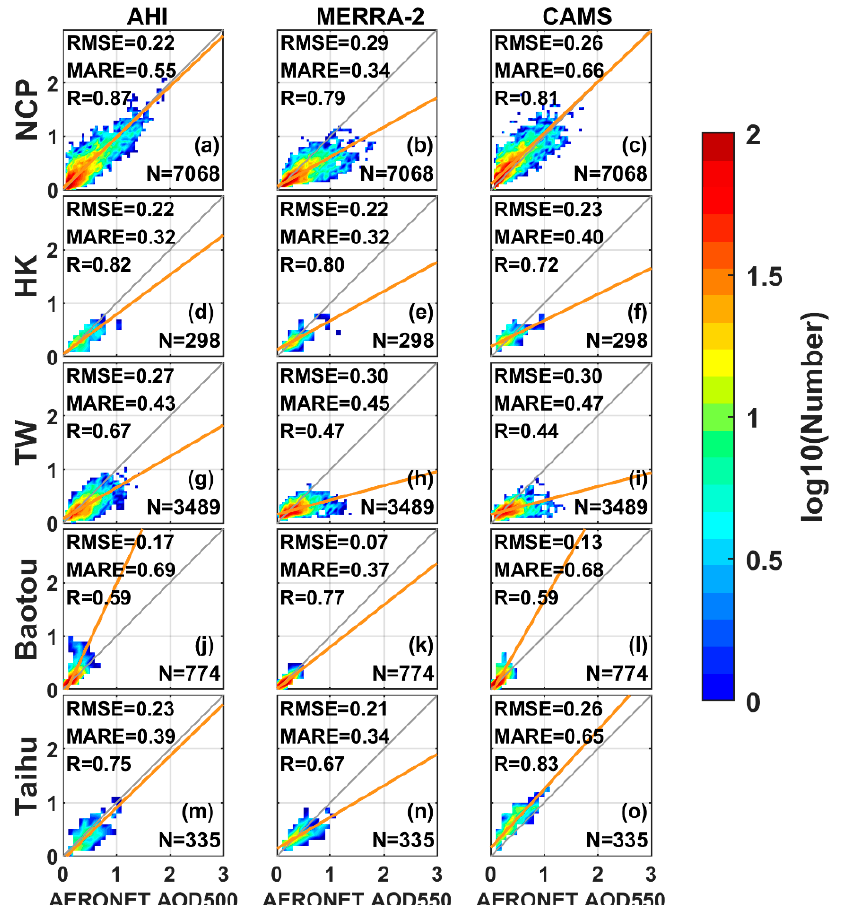
Figure 3. Scatterplots of AODs from AHI, MERRA-2, and CAMS versus AERONET observations in the ( a – c ) NCP, ( d – f ) HK, ( g – i ) TW, ( j – l ) Baotou, and ( m – o ) Taihu regions. The y-axis of columns 1–3 indicates AODs from AHI, MERRA-2, and CAMS, respectively.